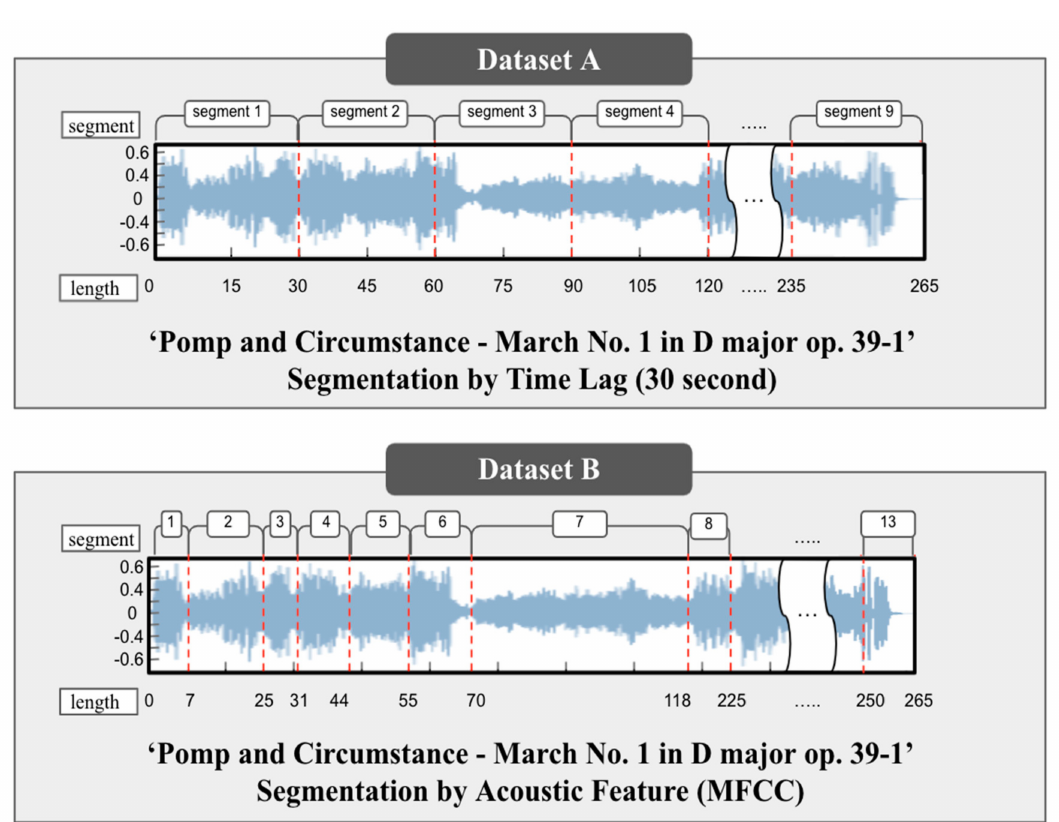
Figure 5. Music Data Segmentation Overview of Dataset A and Dataset